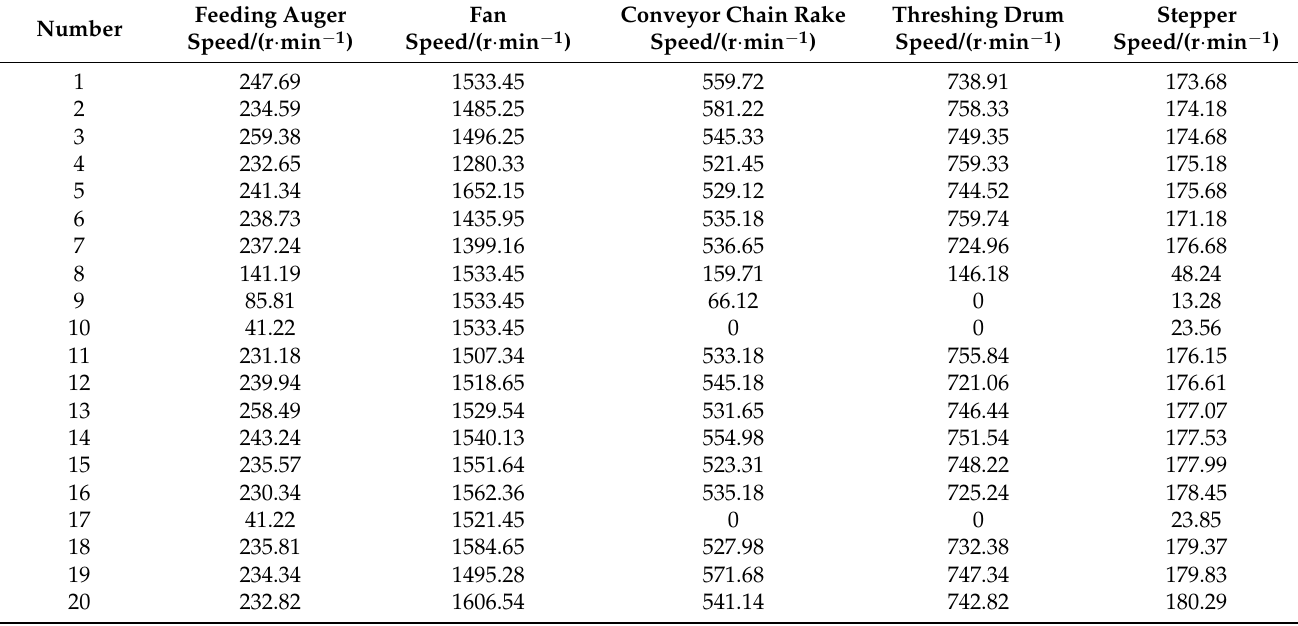
Table 1. Collected data of fault diagnosis